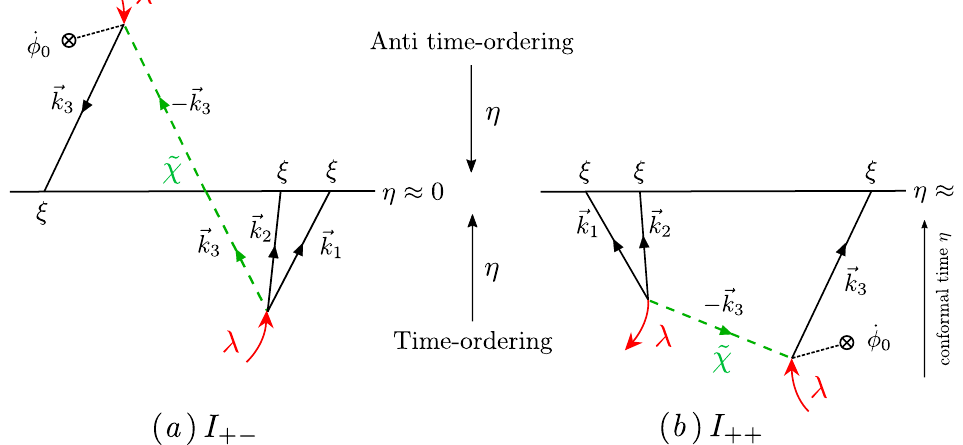
Figure 1. Representation of the dominant tree-level contributions from I + − and I ++ diagrams to the bispectrum. For the convenience of notation, the time ordered part of the diagram is shown below the η ≈ 0 line with time running upwards, while the anti-time ordered part is shown above with time running downwards. An incoming (outgoing) arrow at a vertex denotes injection (extraction) of energy. This makes it plausible that the I contribution is enhanced compared + − to the I contribution, since for the former the “resonant” particle production through energy ++ injection is efficient at both the vertices. Further explanations can be found in the